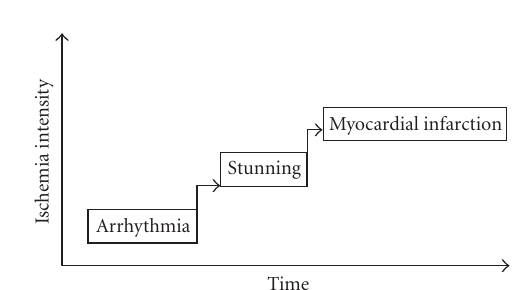
Figure 1: Sequence of pathologic events in ischemia reperfusion